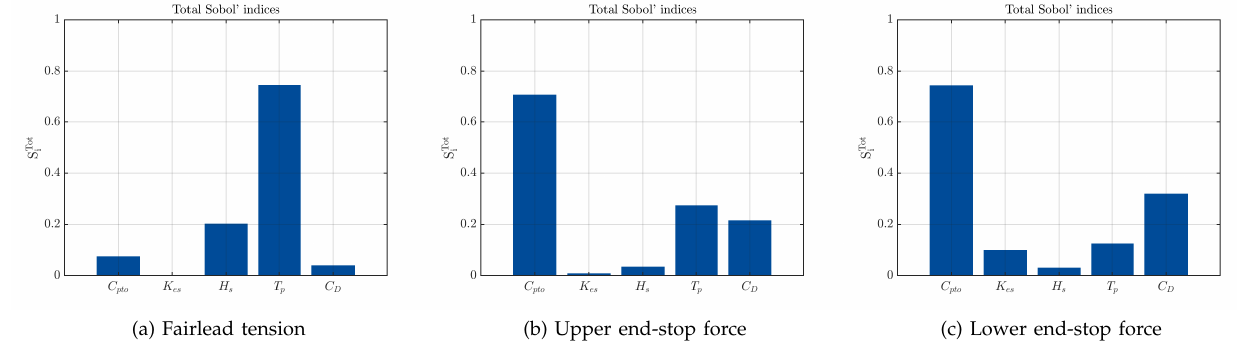
Fig. 8. Total sensitivity index for the ERW1 case using d = 5 .